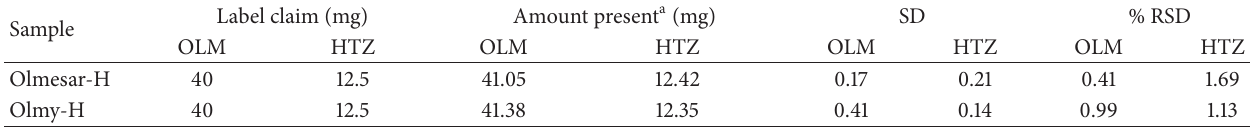
Table 6: Results from HPTLC quantification of olmesartan medoxomil and hydrochlorothiazide in tablets. Sample